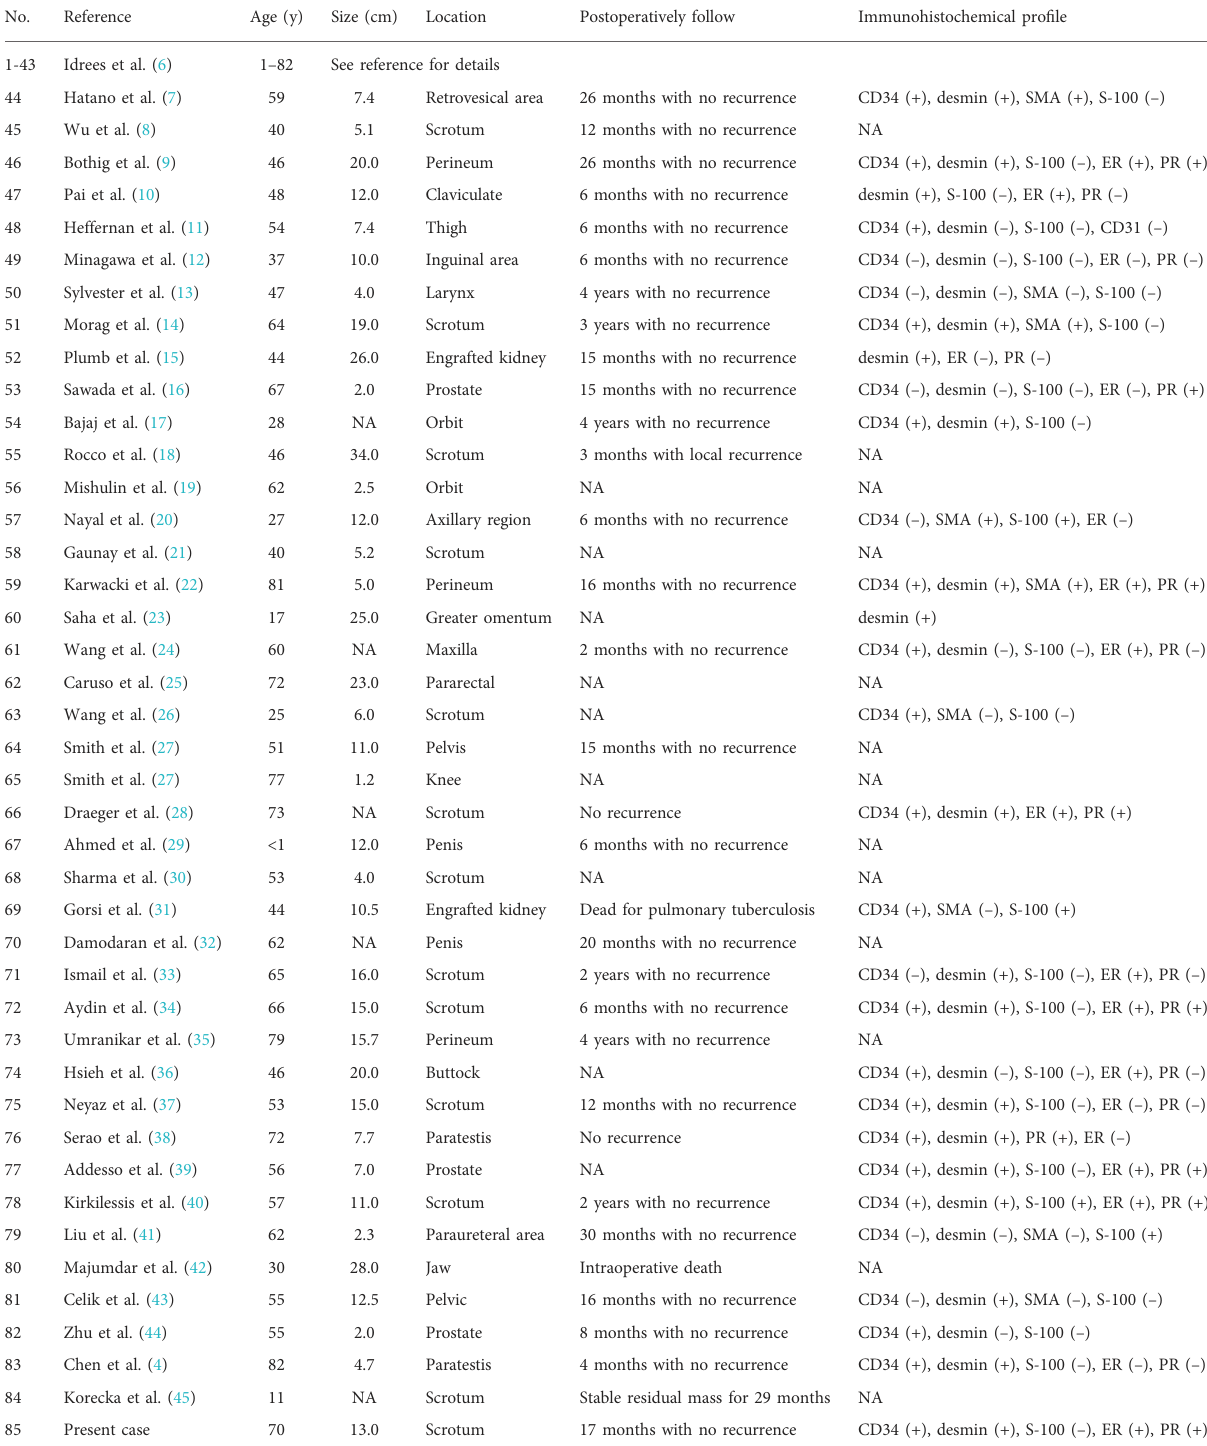
TABLE 1 The previously reported cases of aggressive angiomyxoma in